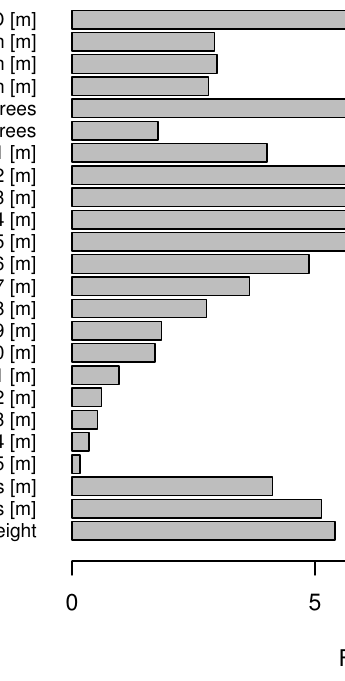
Figure 7. Feature importance derived by the random forest